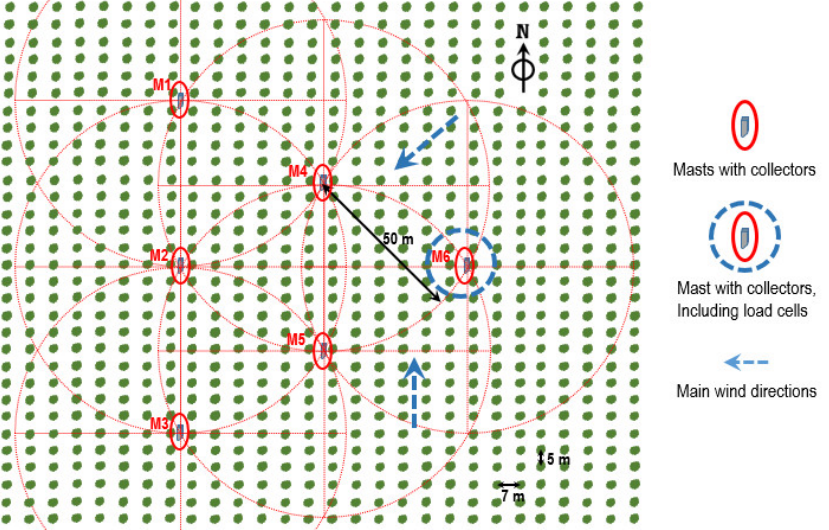
Figure 3. Mast distribution at field and main wind directions.